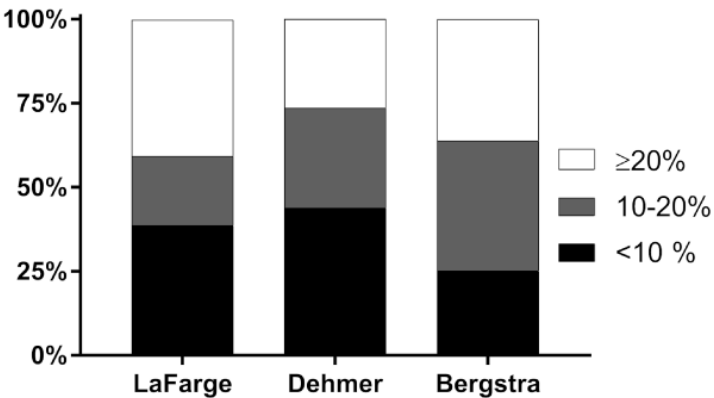
Fig 2. Relative difference between indirect Fick method and thermodilution assessed cardiac index. Black bars indicate the percentage of patients with an error between cardiac index measurements < 10%, grey bars indicate the percentage of patients with an error between cardiac index measurements 10–20%, the white bar indicates the percentage of patients with an error between cardiac index measurements > 20%.